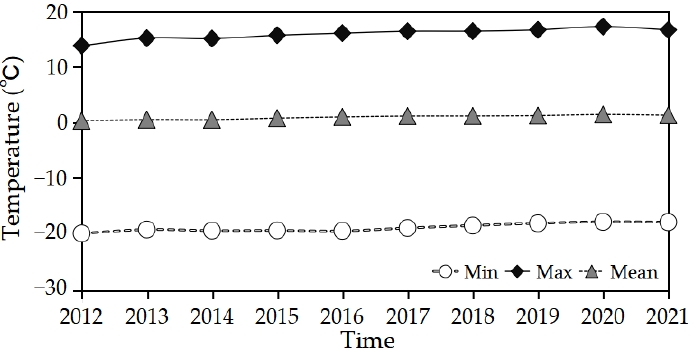
Figure 10. Maximum, minimum and mean of LST maps obtained for each year from MODIS LST products.